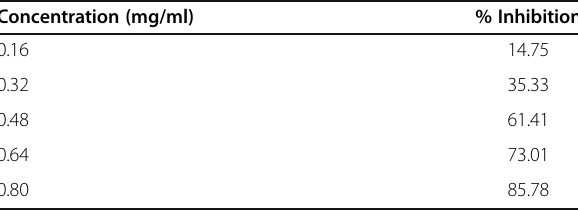
Table 2 DPPH radical-scavenging capacity of the ethyl acetate fraction of Parkia biglobosa